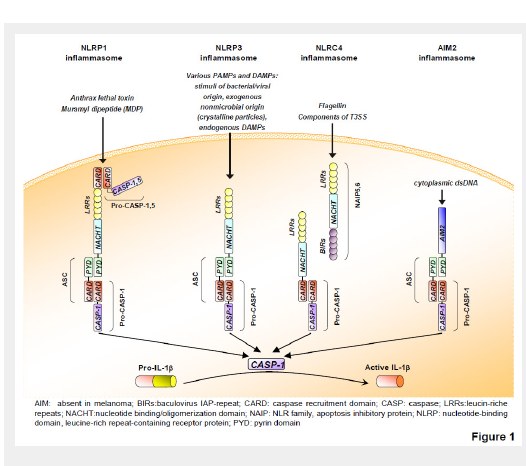
its active, secreted